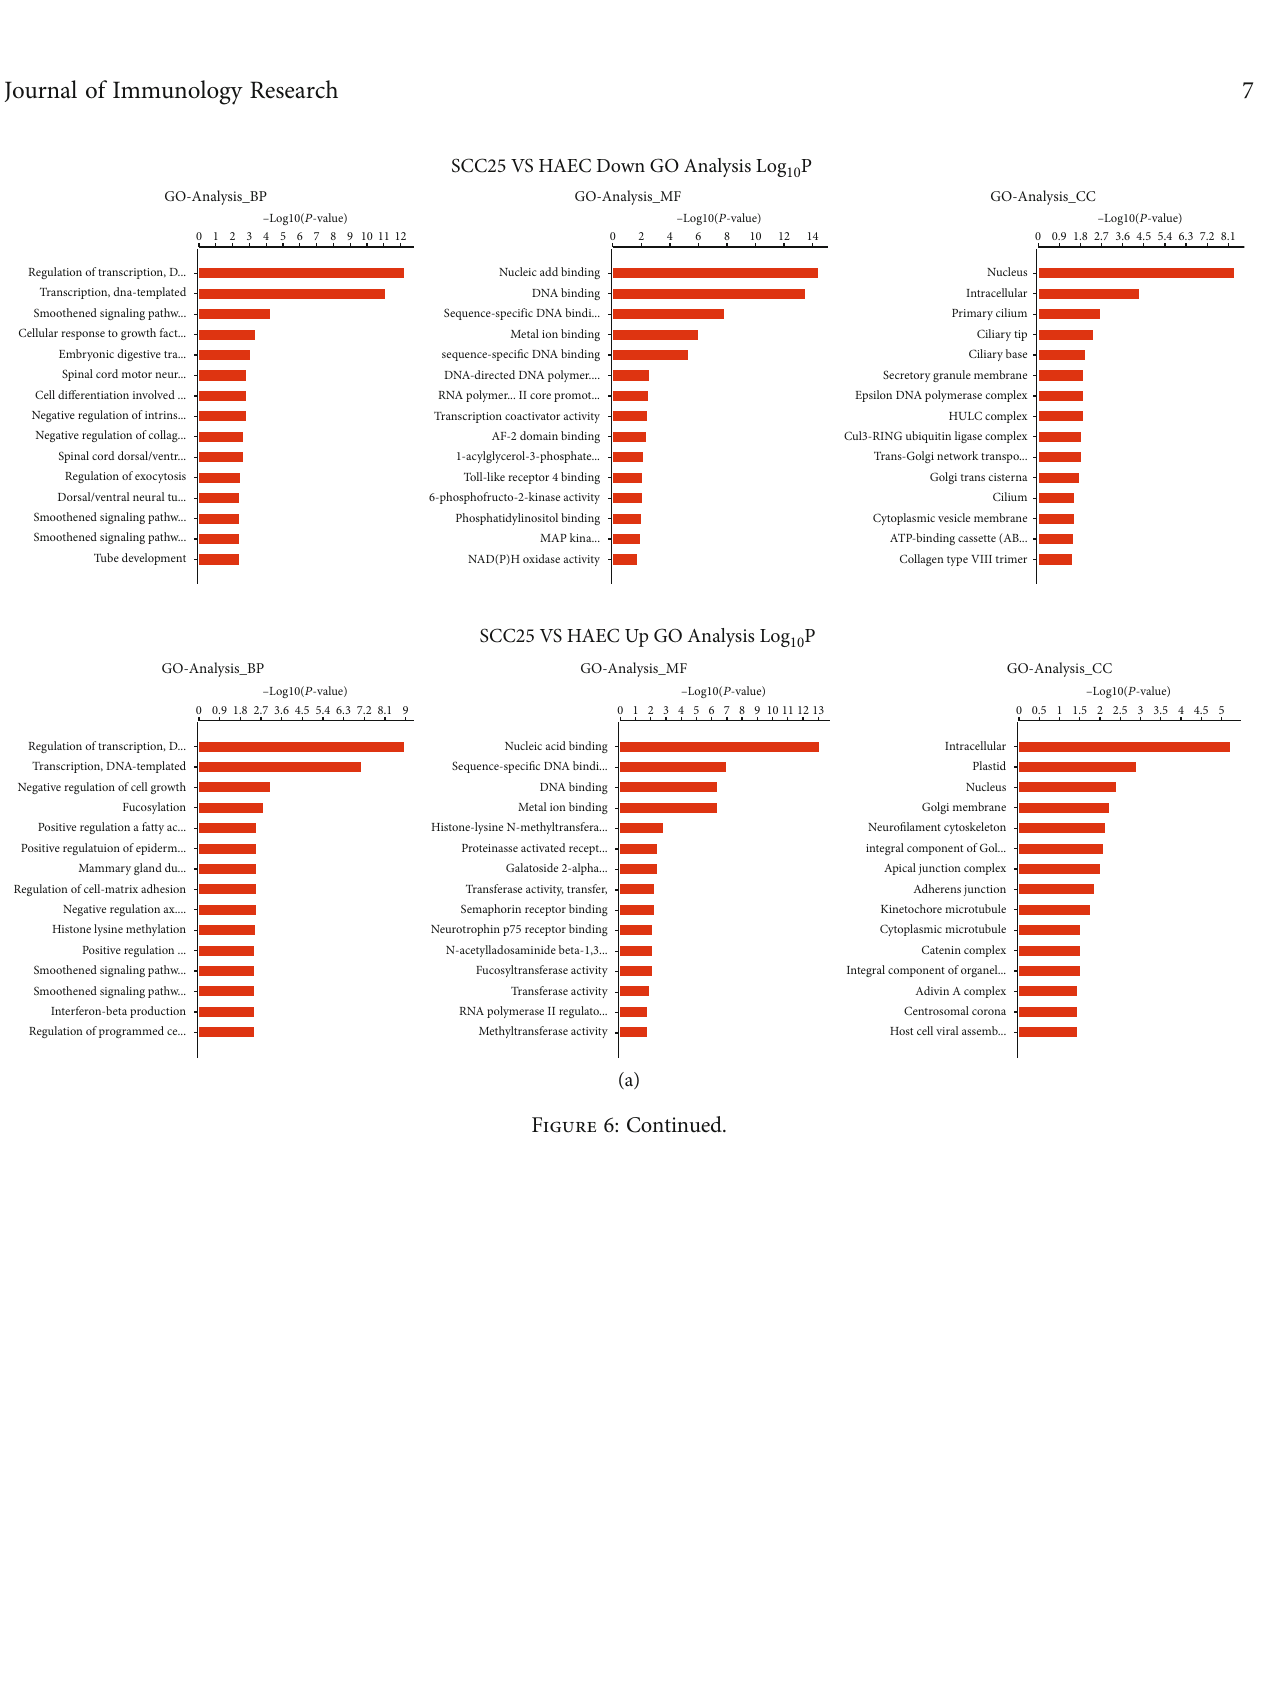
Regulation of transcription, D... Transcription, dna-templated Smoothened signaling pathw... Cellular response to growth fact... Embryonic digestive tra... Spinal cord motor neur... Cell differentiation involved ... Negative regulation of intrins... Negative regulation of collag... Spinal cord dorsal/ventr... Regulation of exocytosis Dorsal/ventral neural tu... Smoothened signaling pathw... Smoothened signaling pathw...